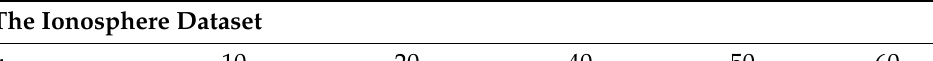
Table 9. F1-score measures of the original iForest and ABIForest as functions of the number of anomalous instances n anom in the Ionosphere dataset under the condition that the number n norm of normal instances was not